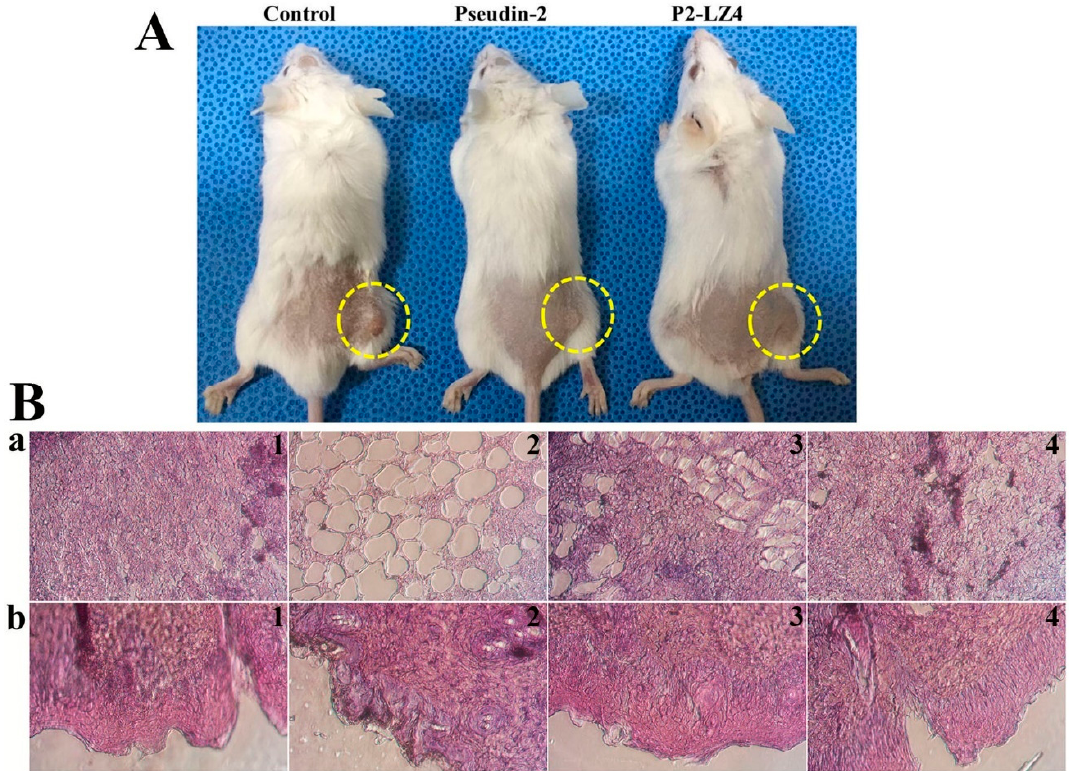
Figure 10. In vivo antifungal activity of pseudin-2 and P2-LZ4 peptides in C. tropicalis -infected mice. ( A ) At 24 h after subcutaneous fungal infection, pseudin-2 and P2-LZ4 peptides were subcutaneously injected, and mice were monitored for seven days. ( B ) Paraffin-embedded skin tissues were sectioned and stained with hematoxylin and eosin. Subcutaneous ( a ) and epidermal tissues were observed under a microscope (magnification: 400×). ( 1 ): PBS, ( 2 ): C. tropicalis , ( 3 ): C. tropicalis with pseudin-2, ( 4 ): C. tropicalis with P2-LZ4.